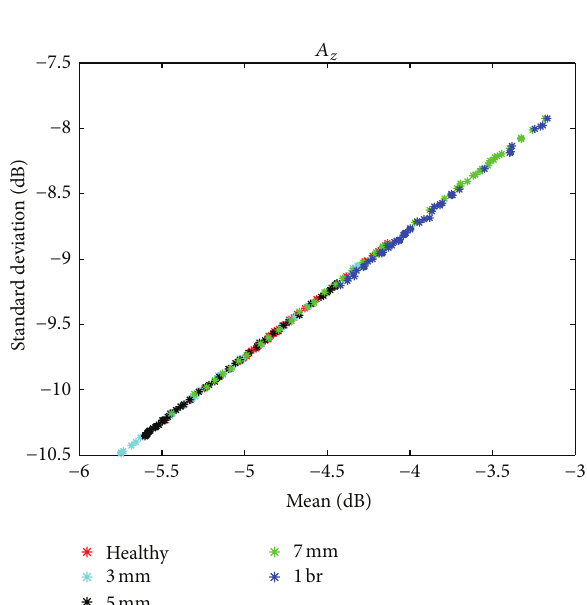
Figure 15: Full-load condition analysis, 𝐴 𝑧 -axis.